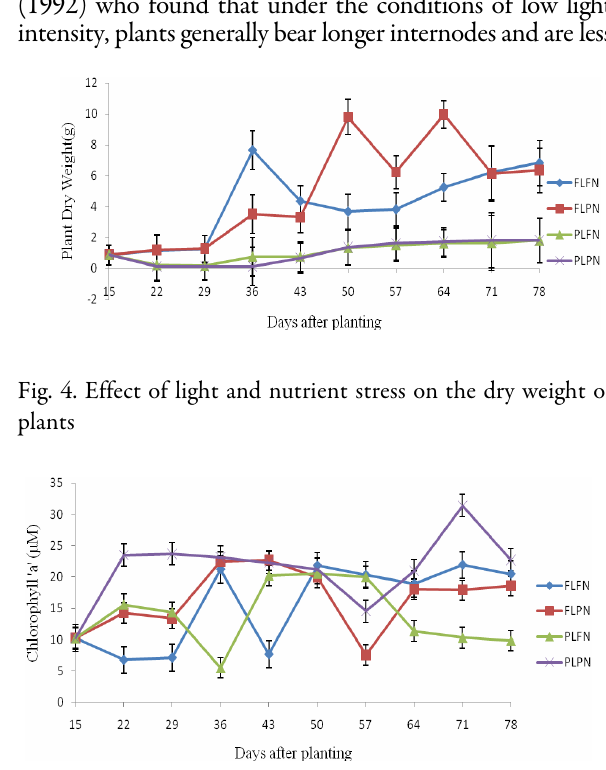
Fig. 5. Effect of light and nutrient stress on chlorophyll a content